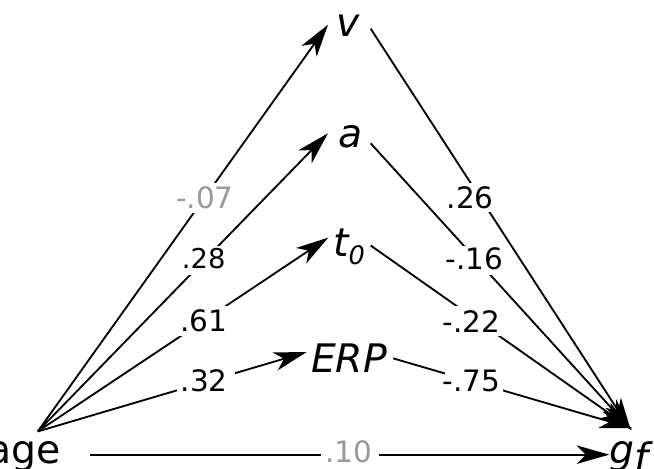
Figure 4. Multiple mediation model of the association between age differences and fluid intelligence. Standardized regression weights are shown next to paths with non-significant regression weights shaded in gray. v = drift rate; a = boundary separation; t 0 = non-decision time; ERP = event-related potential; g f = fluid intelligence. N =